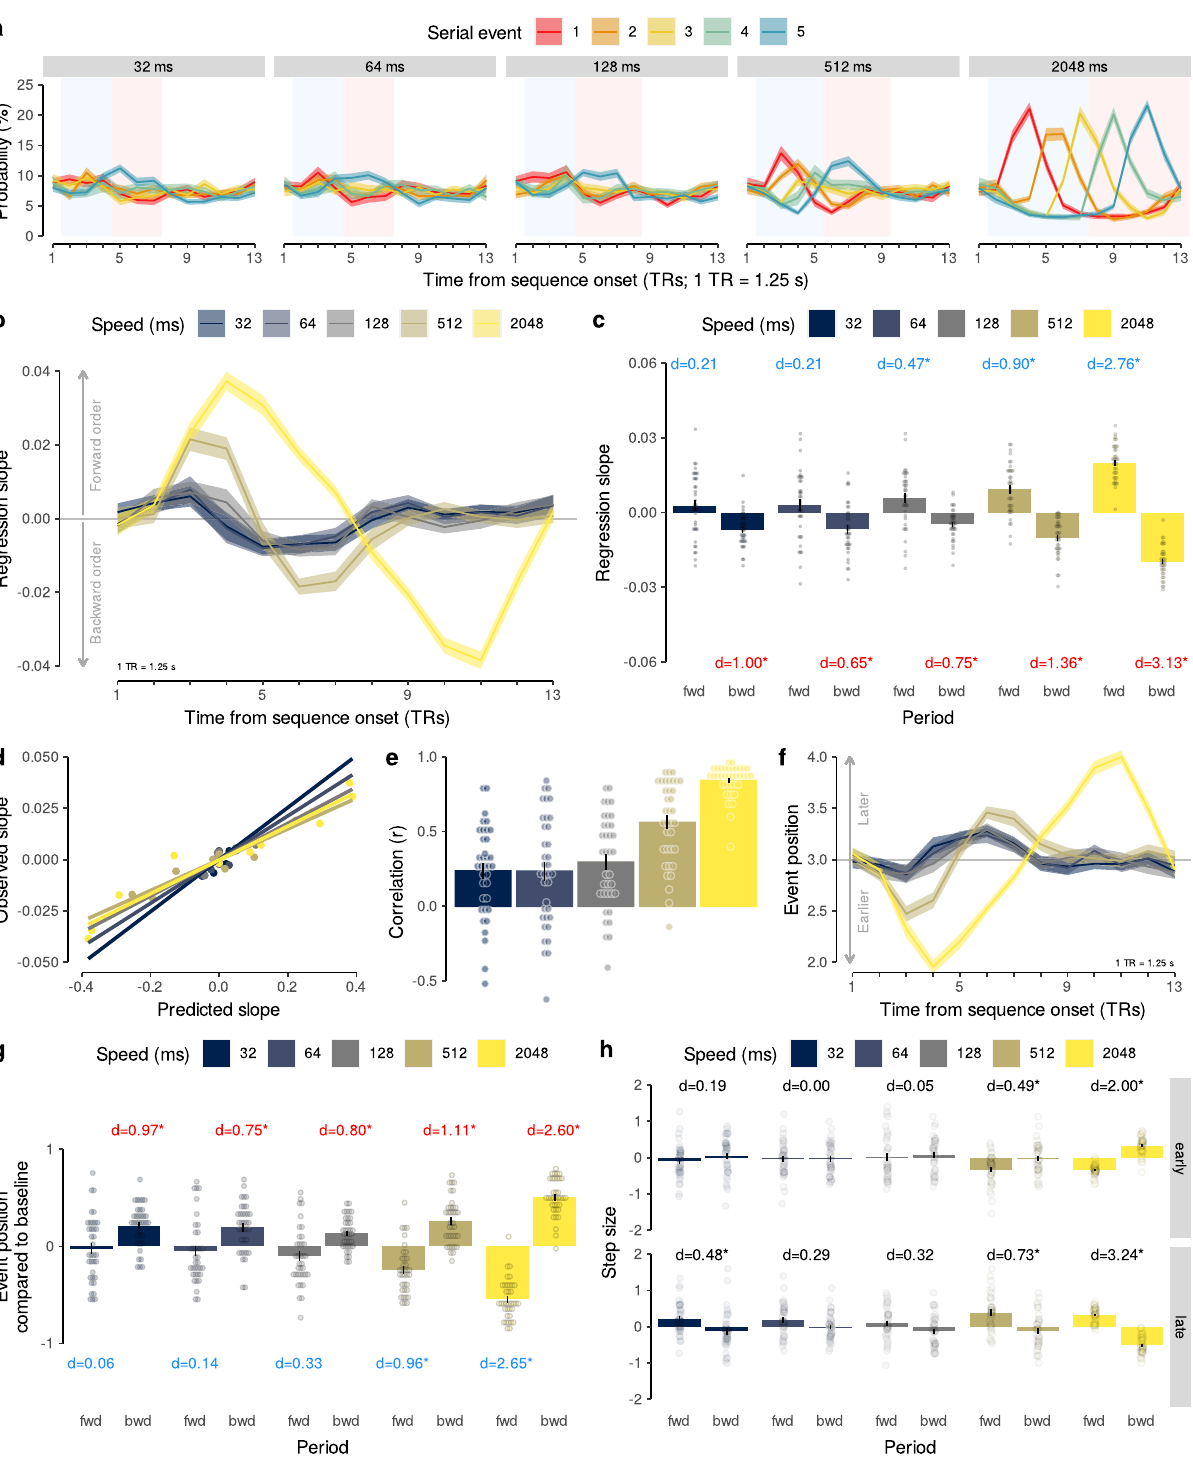
The average serial position of the decoded images was therefore signi fi cantly different between the predicted forward and back- ward period at all sequence speeds (all p s < 0.001, Fig. 3g, Supplementary Fig. 6d). Compared to baseline (mean serial position of 3), the average serial position during the forward period was signi fi cantly lower for speeds of 512 and 2048 ms (all p s < 0.001). The average decoded serial position at later time points was signi fi cantly higher compared to baseline in all speed conditions, including the 32 ms condition (all p s < 0.001).